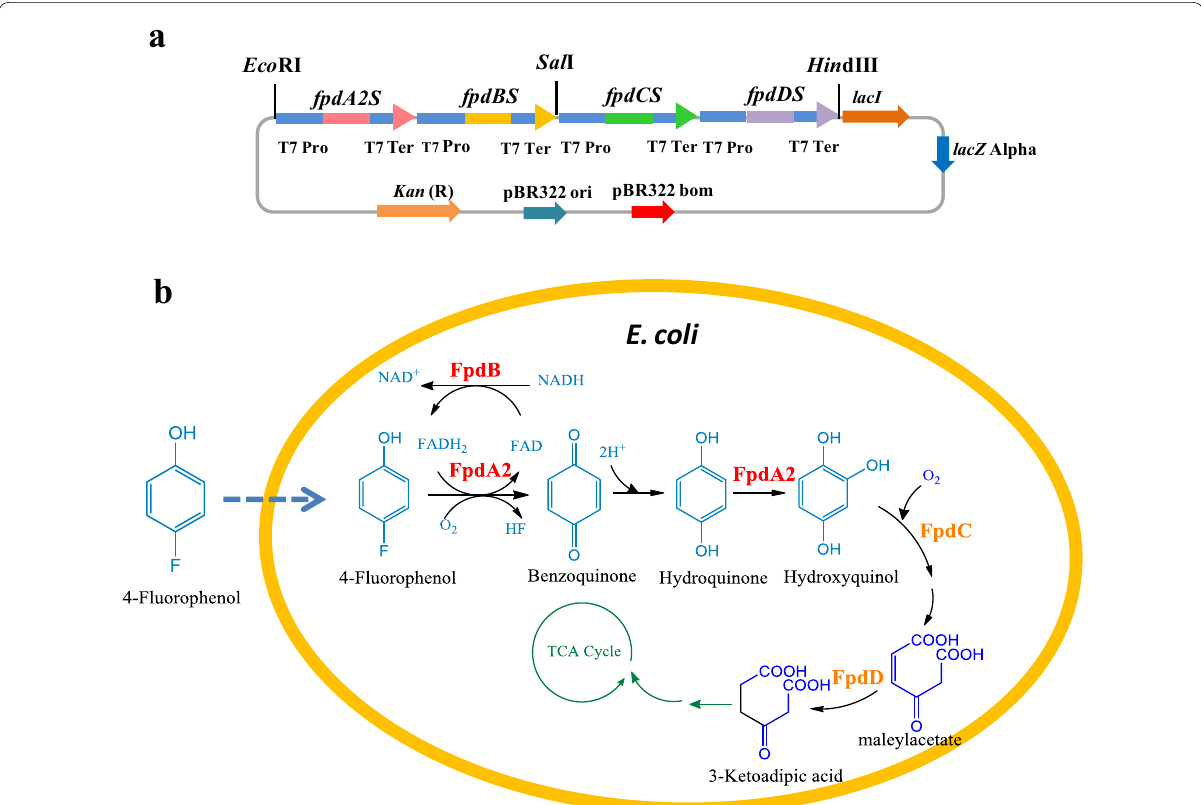
Fig. 1 4-FP degradation pathway constructed in E. coli. a Schematic representation of the multi-monocistronic vector pC1301- fpdA2BCDS ; b Metabolism of 4-FP in recombinant strain BL- fpd . FpdA2, 4-FP monooxygenase; FpdB, flavin reductase; FpdC, hydroxyquinol dioxygenase; FpdD, maleylacetate